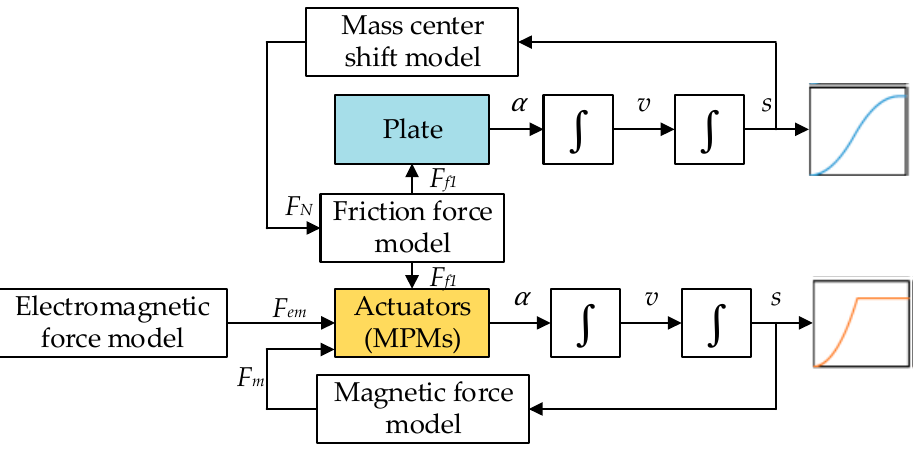
Figure 6. Block diagram of the model in Simulink.